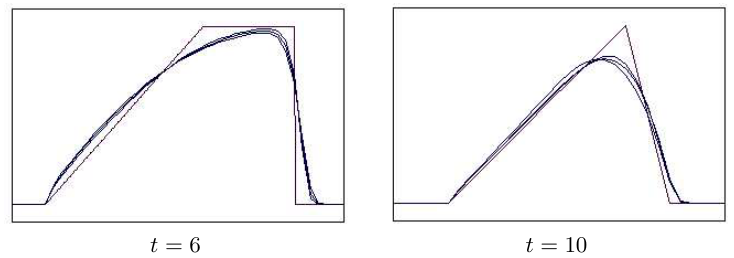
Figure 1. Numerical solution obtained using the implicit upwind scheme for 1 initial data ( (cid:13) = 0 : 1; 0 : 5; 0 : 9